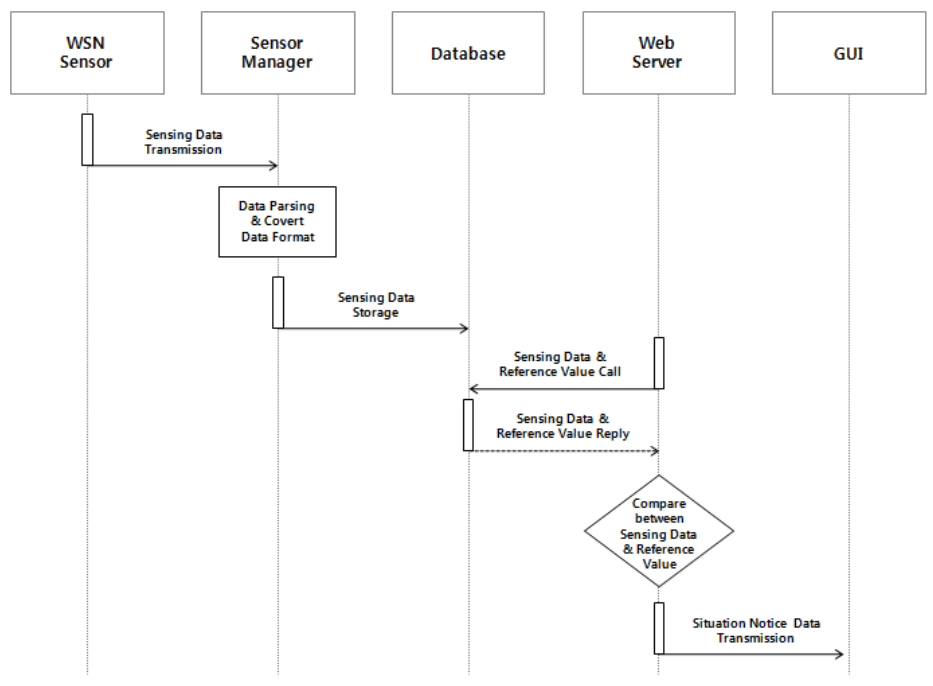
Figure 5. Operation Process of the Condition Notification